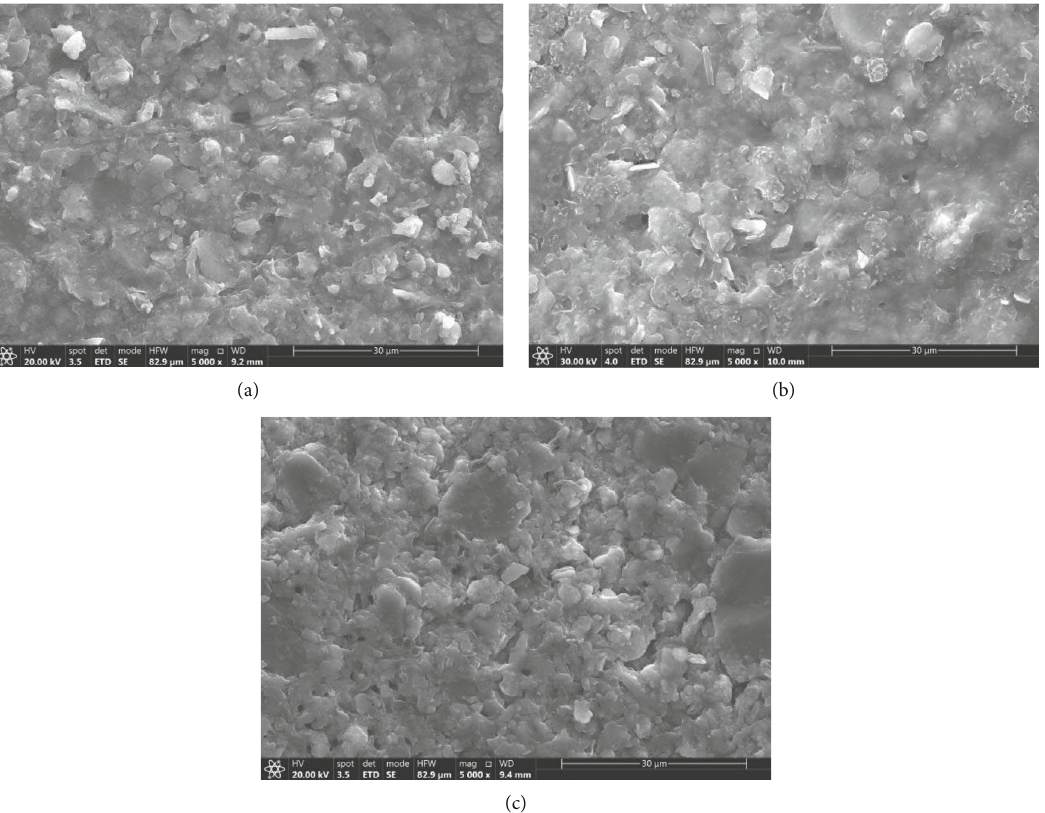
Figure 5: Microstructure with SEM test: (a) 0 freeze-thaw cycle, (b) after 1 freeze-thaw cycle, and (c) after 2 freeze-thaw